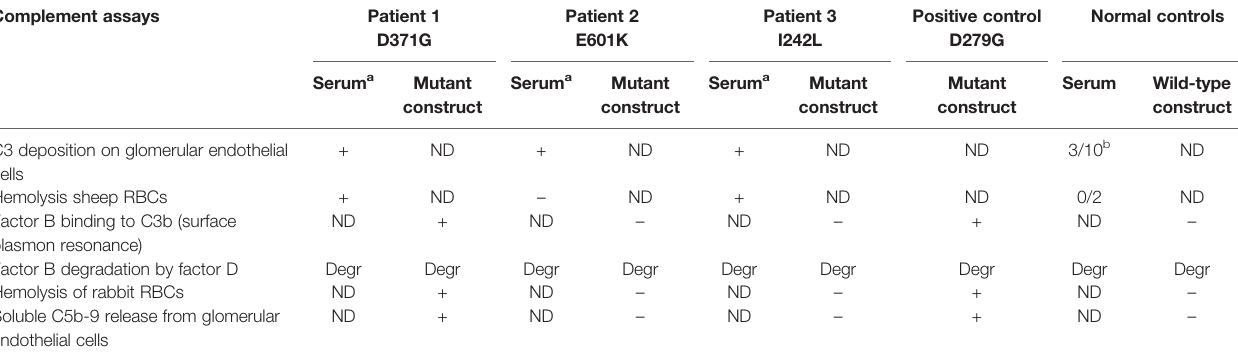
TABLE 2 | Complement functional assays performed in this study using patient sera and mutant